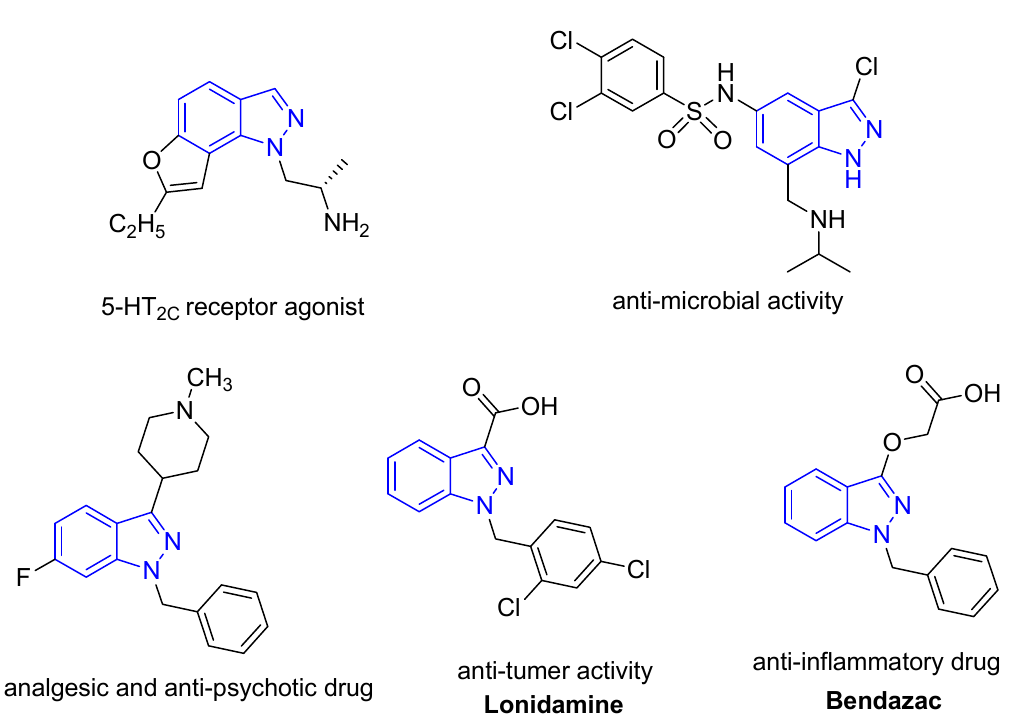
Figure 1. Some biologically active molecules of indazoles.